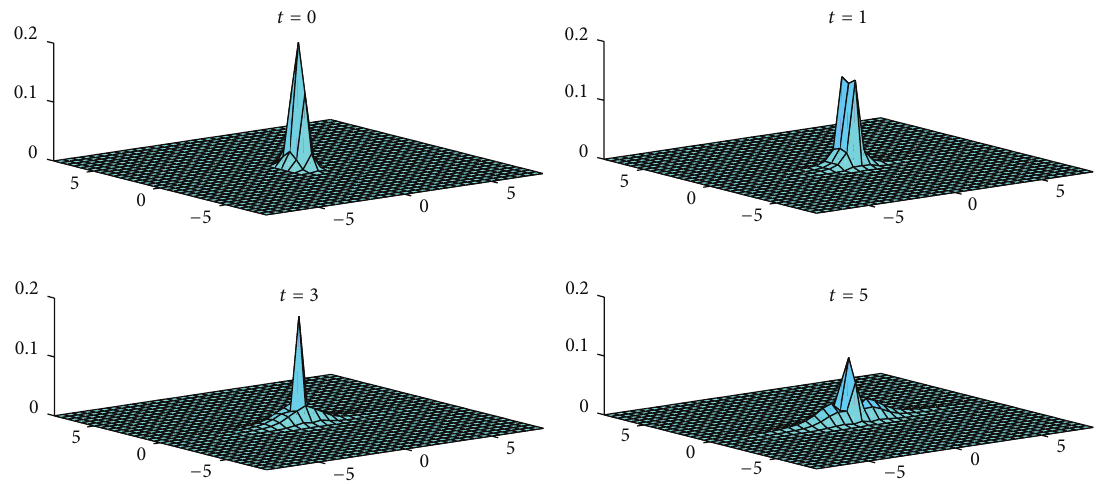
Figure 6: The wave function evolution according to time. Surface plots for |𝜑 2 (𝑥,0,𝑧, 𝑡)| 2 at different